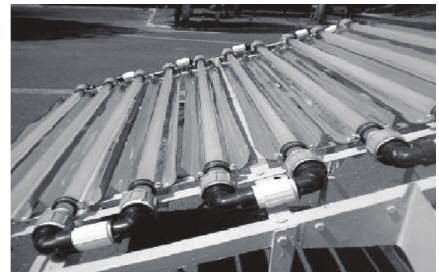
Figure 1: Details of the CPC reactor experimental